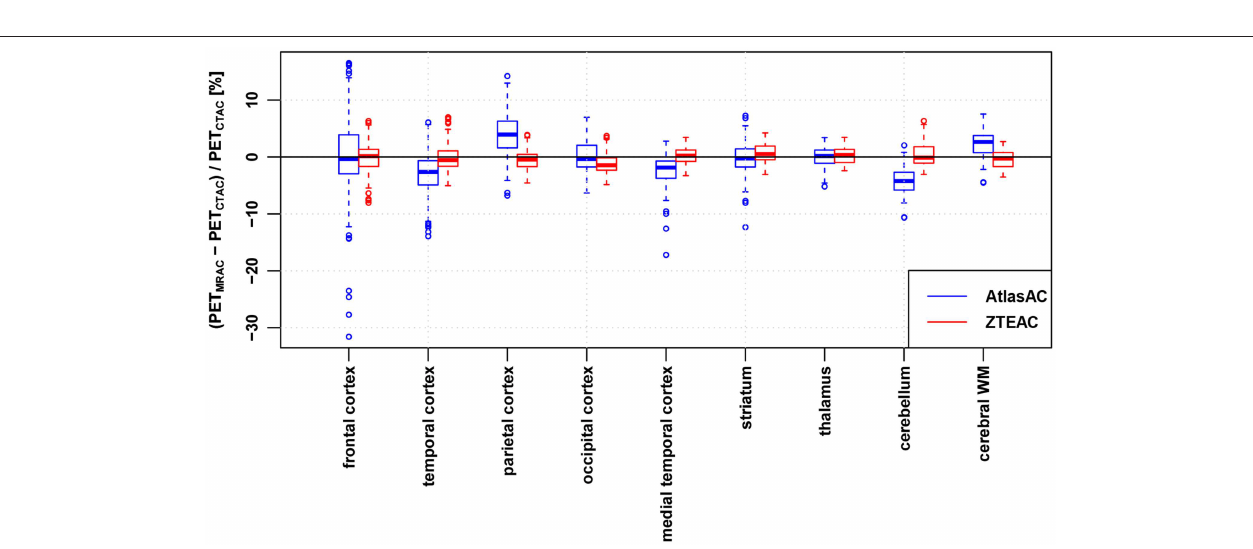
FIGURE 3 | Regional bias in the PET reconstruction caused by AtlasAC (blue) and ZTEAC (red) compared to CTAC as a function of the VOI location in the brain. Please note that the VOIs in the cerebellum had to be excluded in three subjects (6, 7, 21).